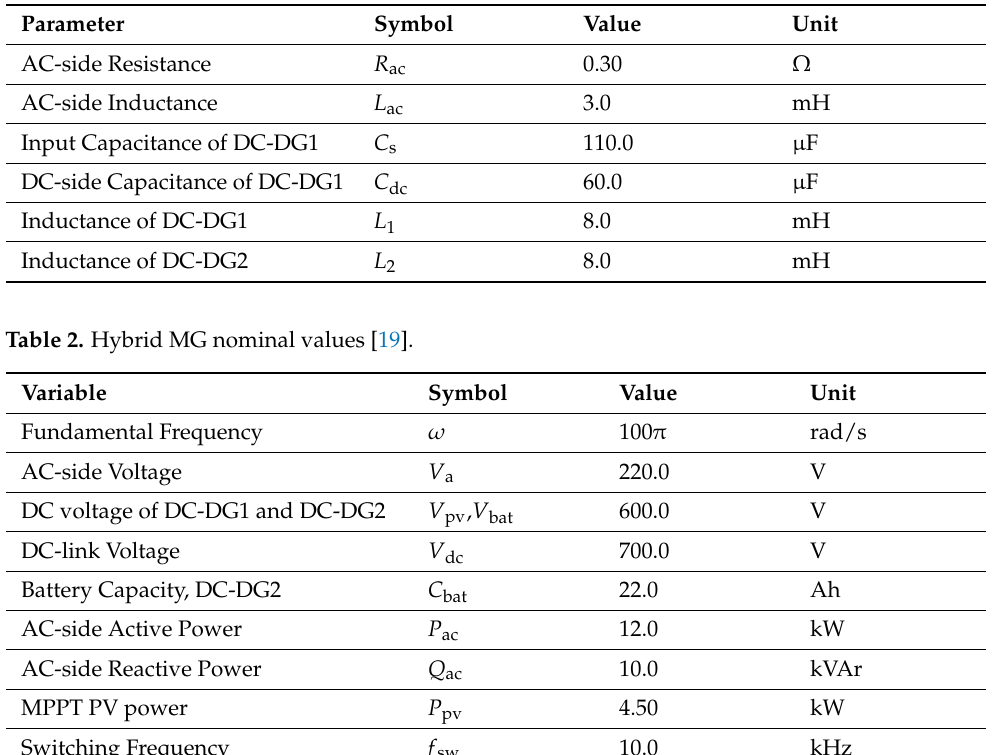
Table 1. Hybrid MG parameters [19].